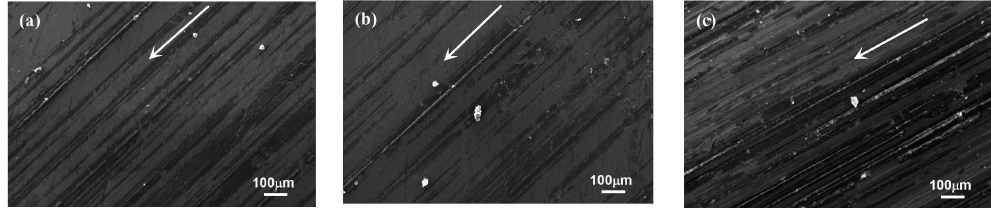
Figure 8. SEM images of the transfer layers under different loads: ( a ) 72 N; ( b ) 362 N; ( c ) 651 N.